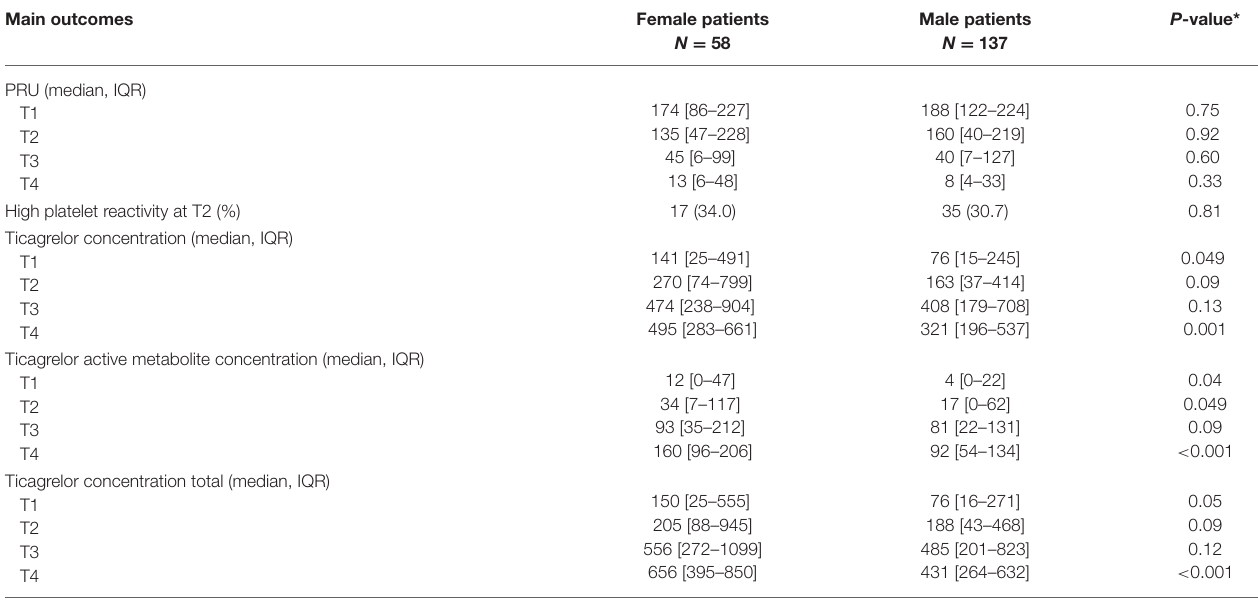
TABLE 2 | Primary and secondary outcomes on pharmacodynamics